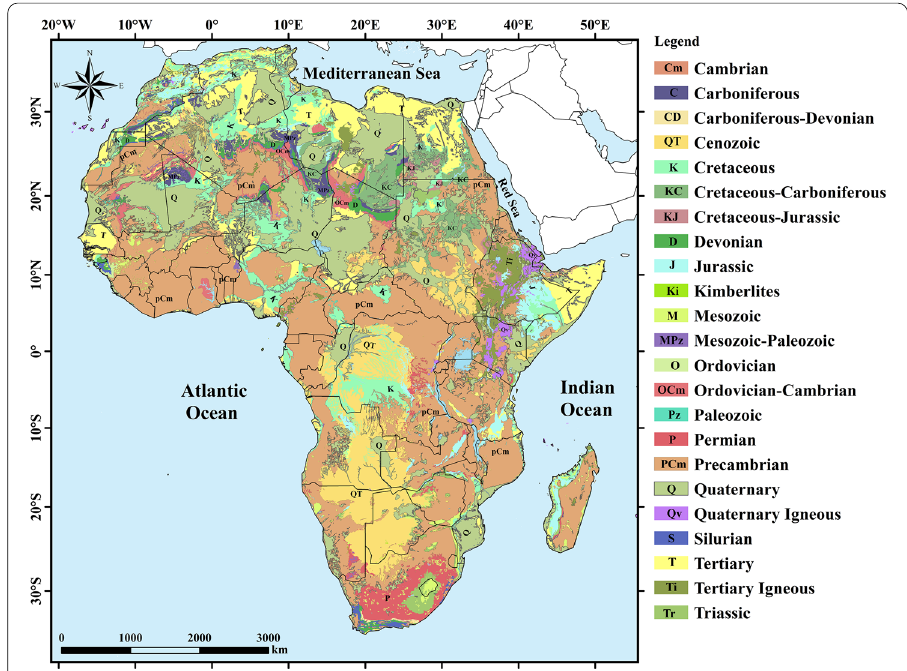
Fig. 3 Surface geological map of African continent, scale 1:10 million (modified after Thiéblemont et al., 2016). The geological map has been simplified to cover the major rock units of clastic sedimentary,